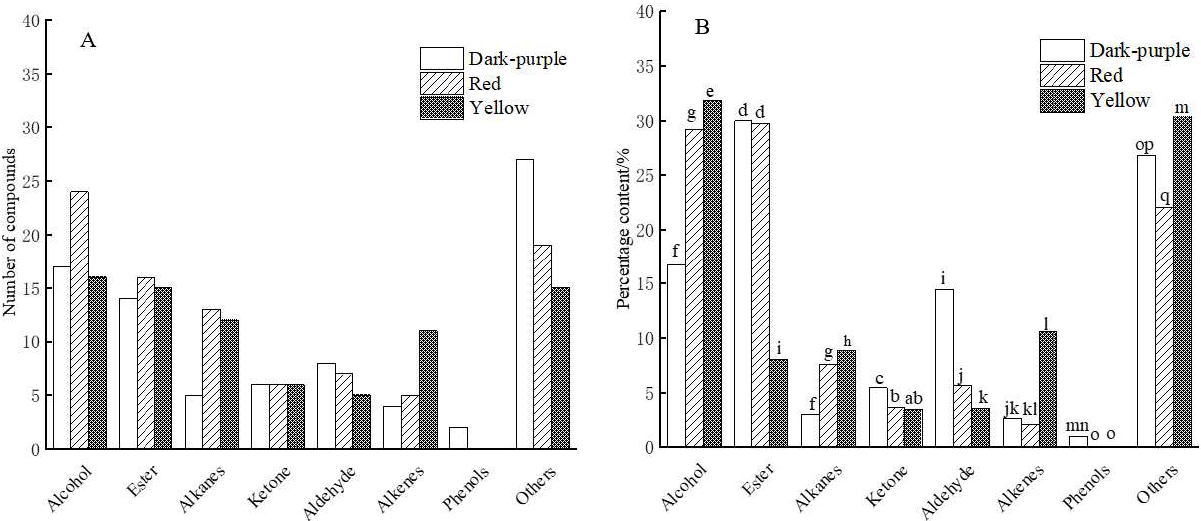
Figure 1. Comparison of number and content of different types of compounds in P. delavayi essential oil with different flower colors. ( A ): Number of compounds. ( B ): Content percentage of compound. Different lowercase letters in the same class of compounds in the figure indicate significant differences ( p < 0.05).